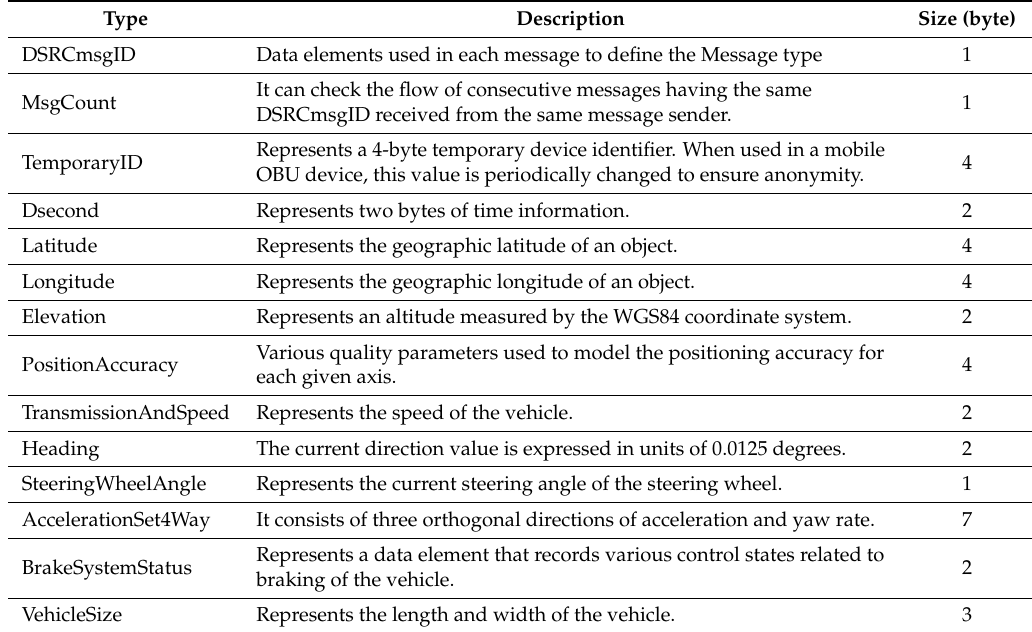
Table 2. Basic safety message (BSM)